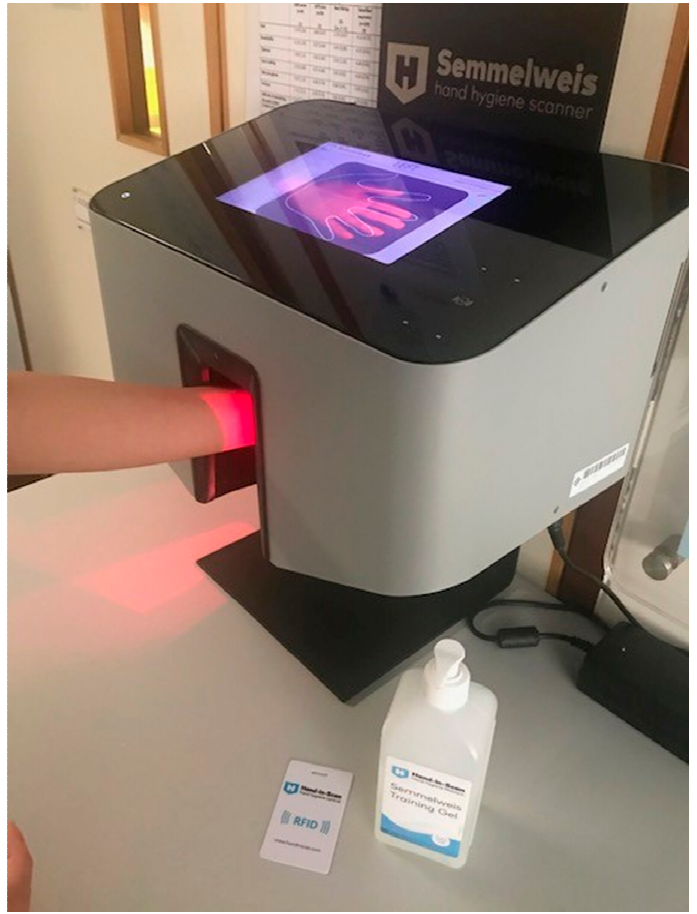
Figure 1. ‘Hand-in-Scan’ device.